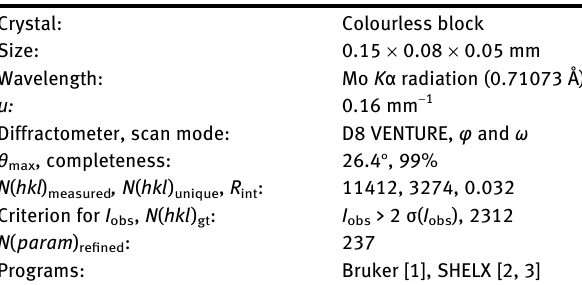
Table  : Data collection and